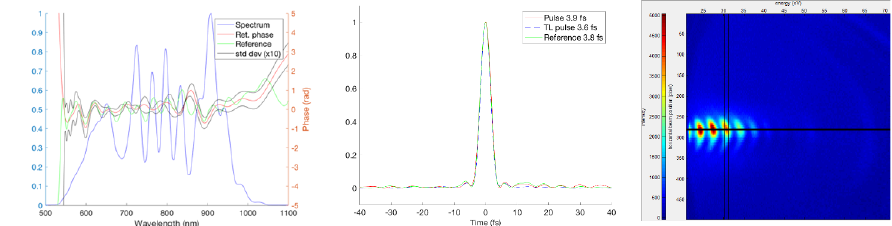
Fig. 2. (a) Spectrum and retrieved spectral phase for SEA-F-SPIDER and THG d-scan. (b) Pulse intensity profiles. (c) Spatio-spectral measurement of HHG in argon. Acknowledgments: Fundação para a Ciência e a Tecnologia (FCT), Portugal (Grants ‘UltraGraf’ M- ERA-NET2/0002/2016, UID/ NAN/50024/2013, NORTE-01- 0145-FEDER-022096 and the Network of Extreme Conditions Laboratories -